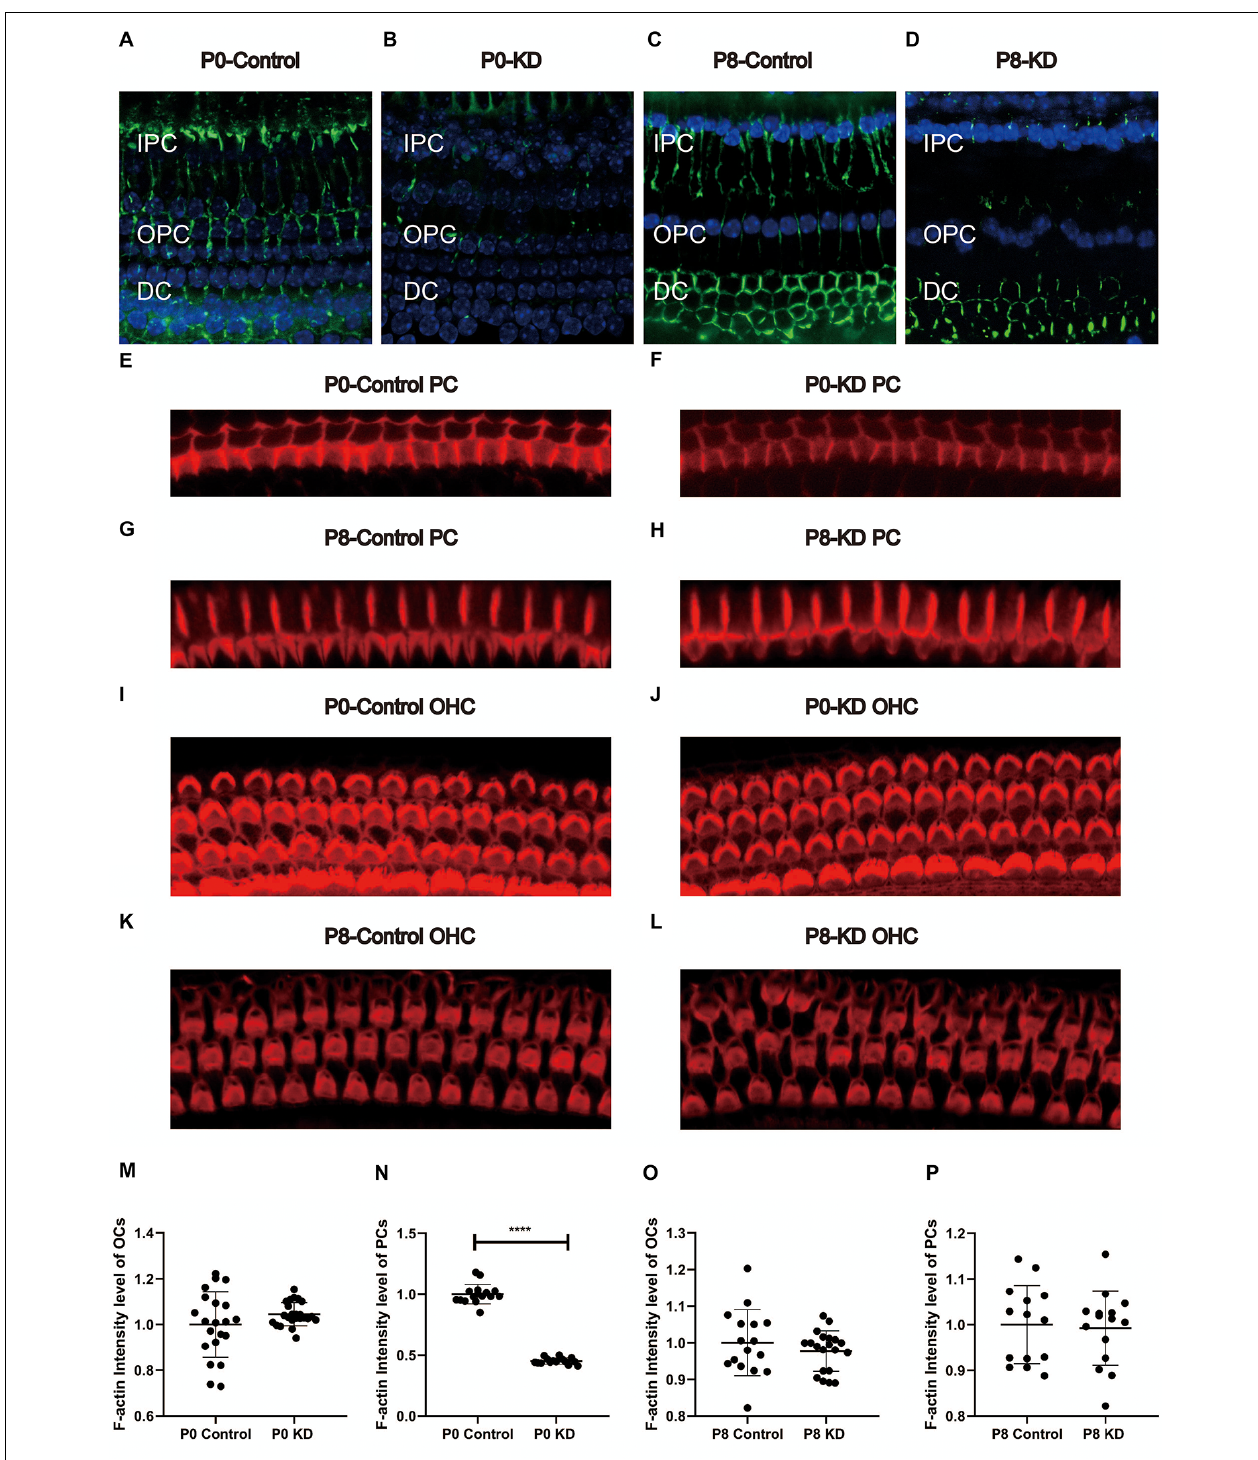
FIGURE 3 | Immunofluorescence staining of Cx26 and F-actin at p6 in P0 KD and p8 KD group. Immunofluorescence staining of Cx26 of support cell in P0 control (A) , P0 KD groups (B) , P8 control (C) , and P8 KD (D) . Staining of microfilaments labeled at the top of the pillar cells with phalloidin in P0 control (E) , P0 KD groups (F) , P8 control (G) , and P8 KD (H) . Staining of microfilaments labeled at outer hair cells with phalloidin in P0 control (I) , P0 KD groups (J) , P8 control (K) , and P8 KD (L) . Statistics of F-actin fluorescence intensity of PCs or OCs ( M – P ; n = 3 in each group). All the staining were performed 7 days after injection of TMX. Scale bar: ∼ 10 µ m (A–L) . IPC, inner pillar cells; OPC, outer pillar cells; DC, Deiter’s cells. ****Significantly different from the control group ( P < 0.0001).